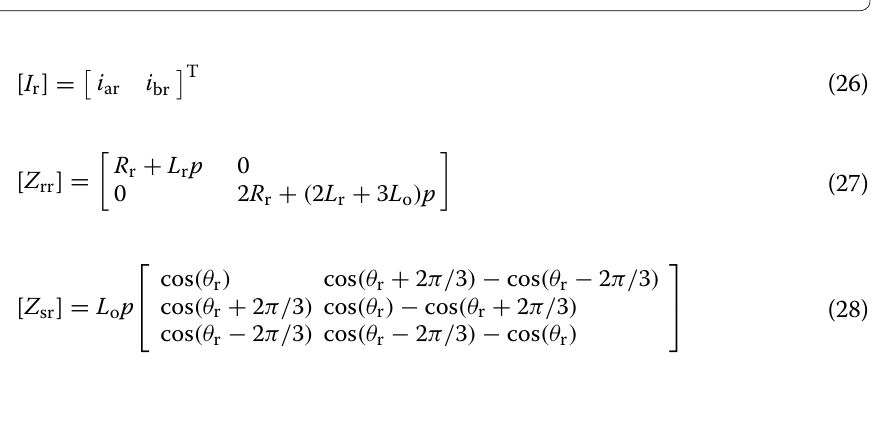
Fig. 2 Motor performance for isolated neutral star connection, a motor speed, b electromagnetic torque, c stator phase current and d rotor